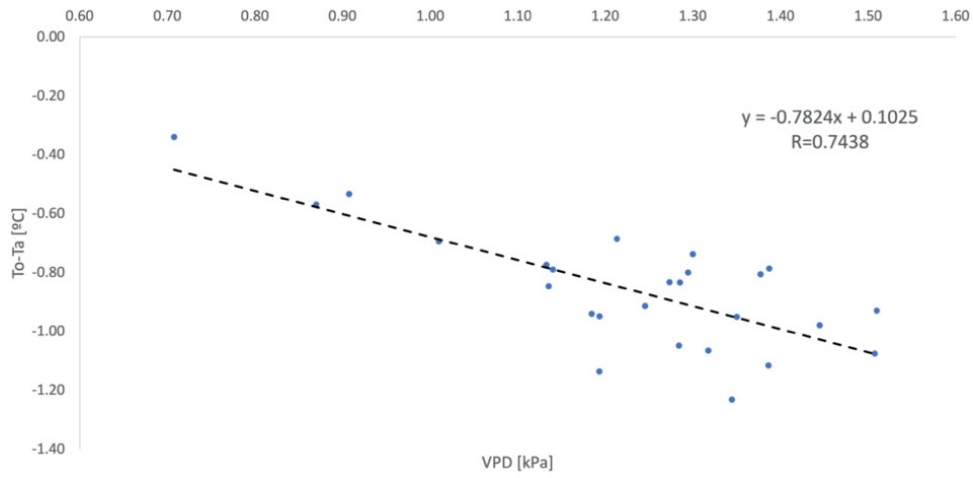
Figure 6. Non-Water-Stressed Baseline Parameterization defined for the protected environment (NWSB P ). Vapor Pressure Deficit (VPD).